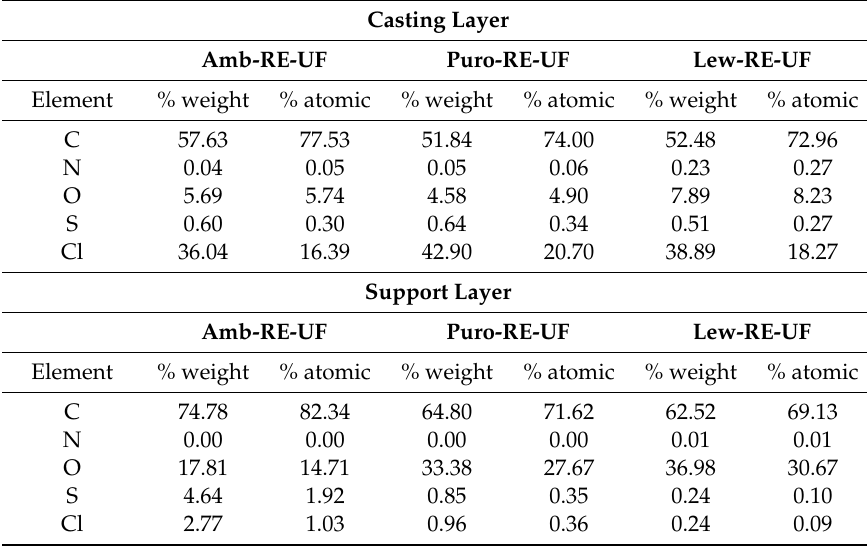
Table 3. Chemical composition analysis by EDX: surface casting layer and polyester layer of the membranes with